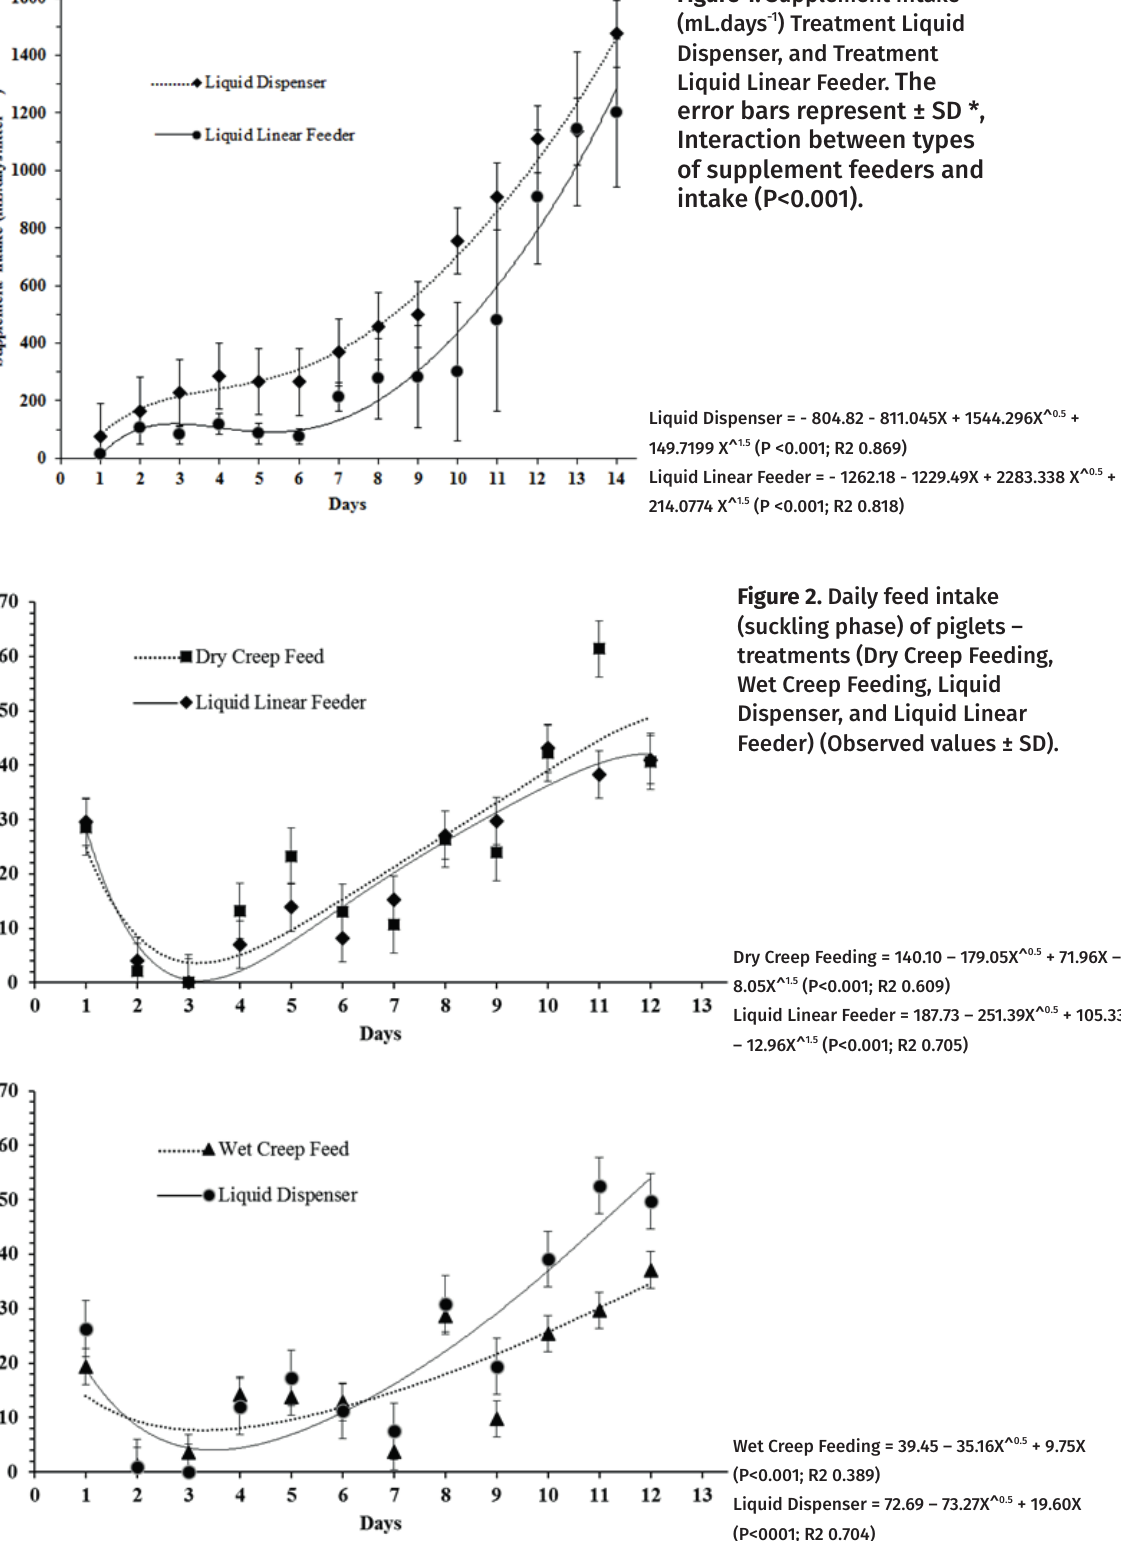
Liquid Dispenser = - 804.82 - 811.045X + 1544.296X^ 0.5